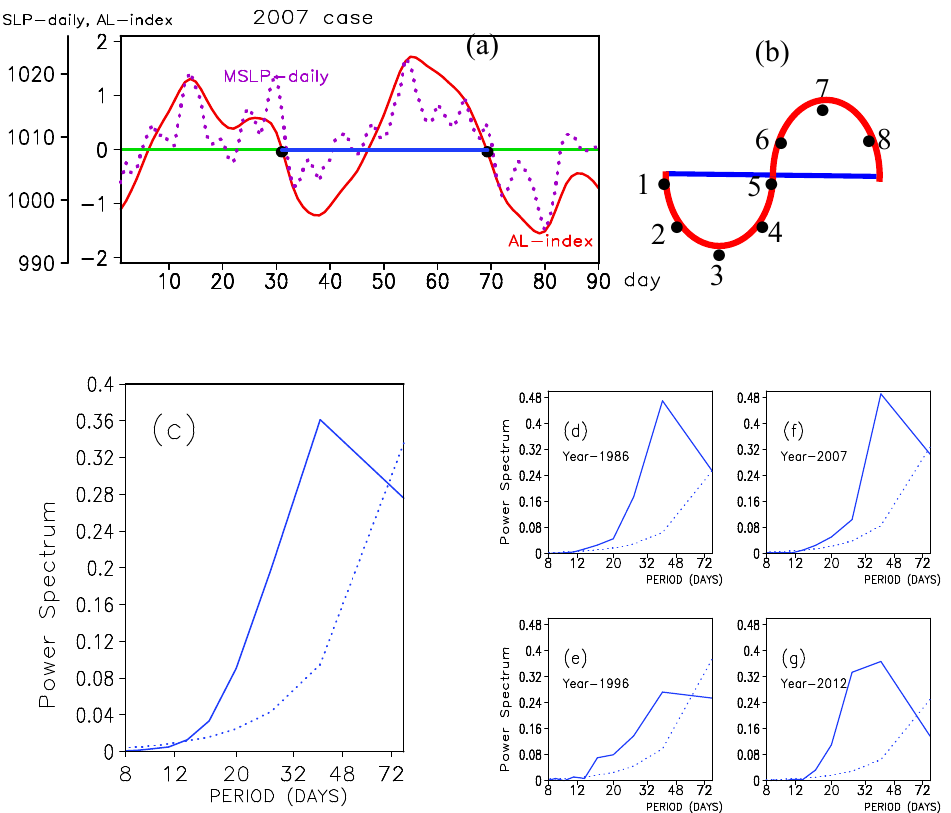
Figure 2. ( a ) Time series of daily MSLP for the region over 160 ◦ E–140 ◦ W, 30–65 ◦ N (box in Figure 1) (purple dotted line, in hPa) and the Aleutian Low index (ALI) on a 20 to 80-day time-scale (ALI, red line) for the winter of 2007. The black dots and blue line indicate the beginning and end of an identified event. ( b ) A diagram showing eight phase points for composition. ( c ) Averaged power spectra of ALI in winters between 1979–2014 and ( d – g ) in four individual winters (1986, 1996, 2007, and 2012). The dotted lines in ( c – g ) are the spectrum of 95% confidence level. Each AL oscillation event is divided into eight phases. Figure 2b shows the eight phases. Phase